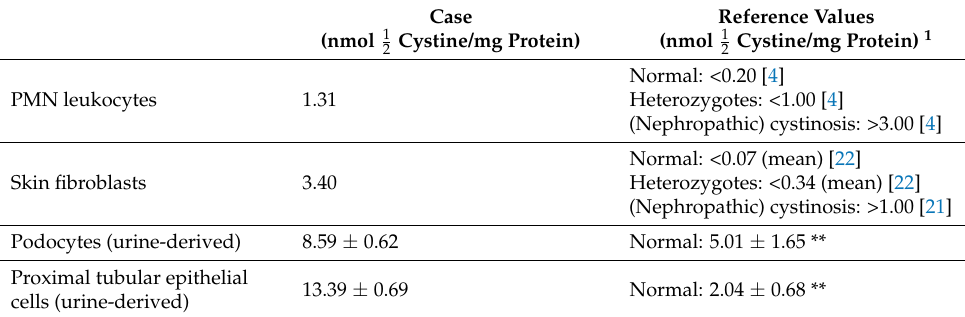
Table 2. Cystine levels measured in different tissue cells.